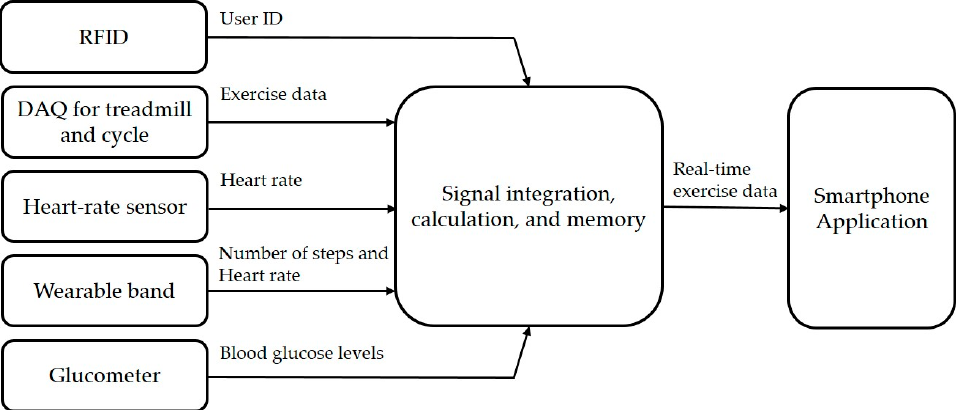
Figure 3. The data flow of the proposed therapeutic exercise platform.